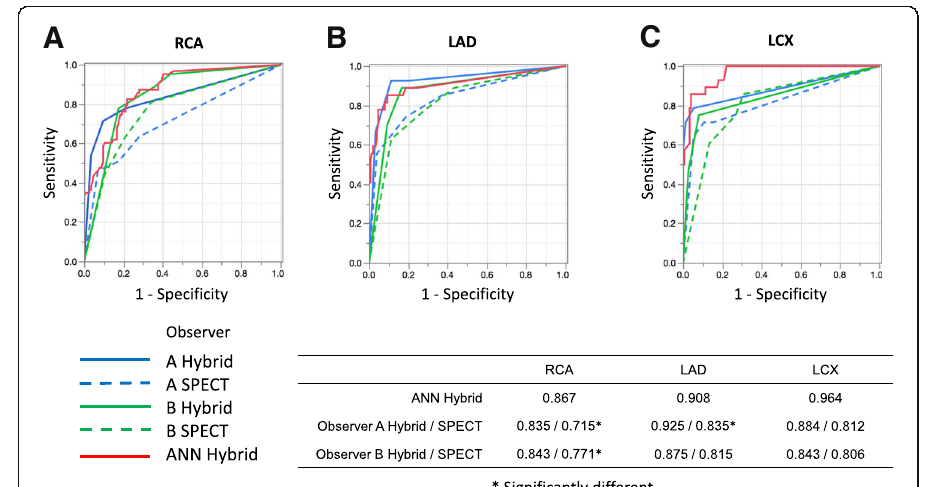
Fig. 4 Areas under ROC curves derived from analysis of RCA ( a ), LAD ( b ), and LCX ( c ) by ANN and two observers using hybrid images and SPECT. ANN artificial neural network, LAD left anterior descending coronary artery, LCX left circumflex coronary artery, RCA right coronary artery, ROC receiver operating characteristic, SPECT single-photon emission computed tomography